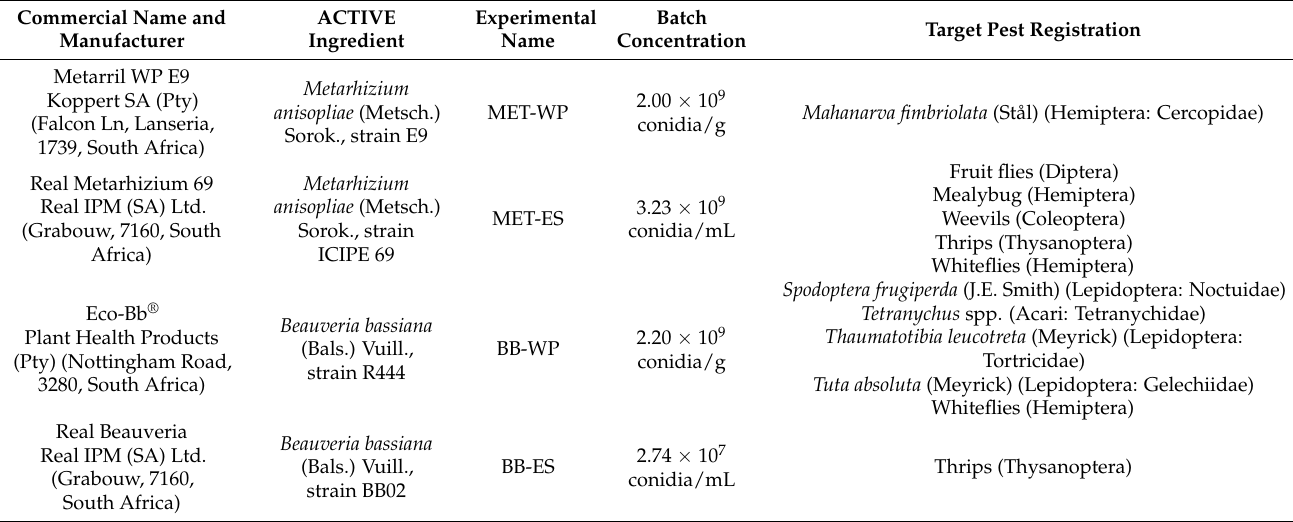
Table 1. Commercial entomopathogenic fungi used and their respective target pests as per product